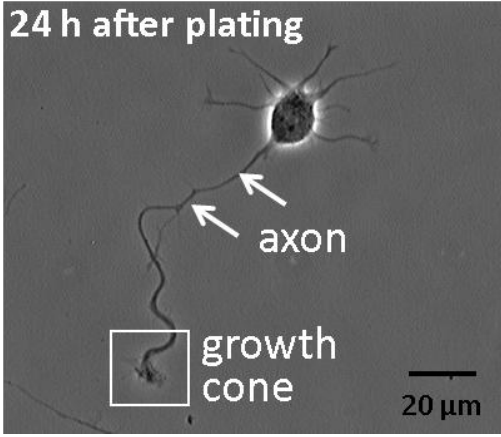
Figure 1. Morphology of hippocampal pyramidal neurons at an early stage of development in low-density dissociated cultures. Shown is a phase contrast image of a representative embryonic rat hippocampal pyramidal neuron 1-day after plating. It illustrates the typical appearance of the newly formed axon, tipped by a growth cone. Several shorter processes emerging from the cell body are nascent